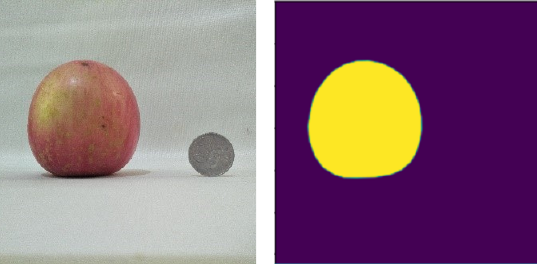
Fig. 5 Segmentation result using both Mask R-CNN and